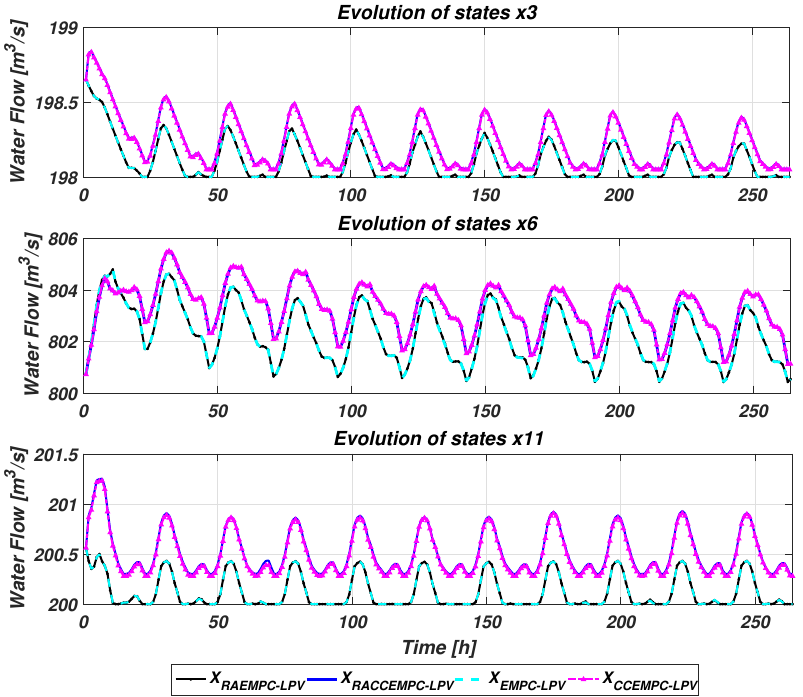
Figure 6. Results of the evolutions of storage